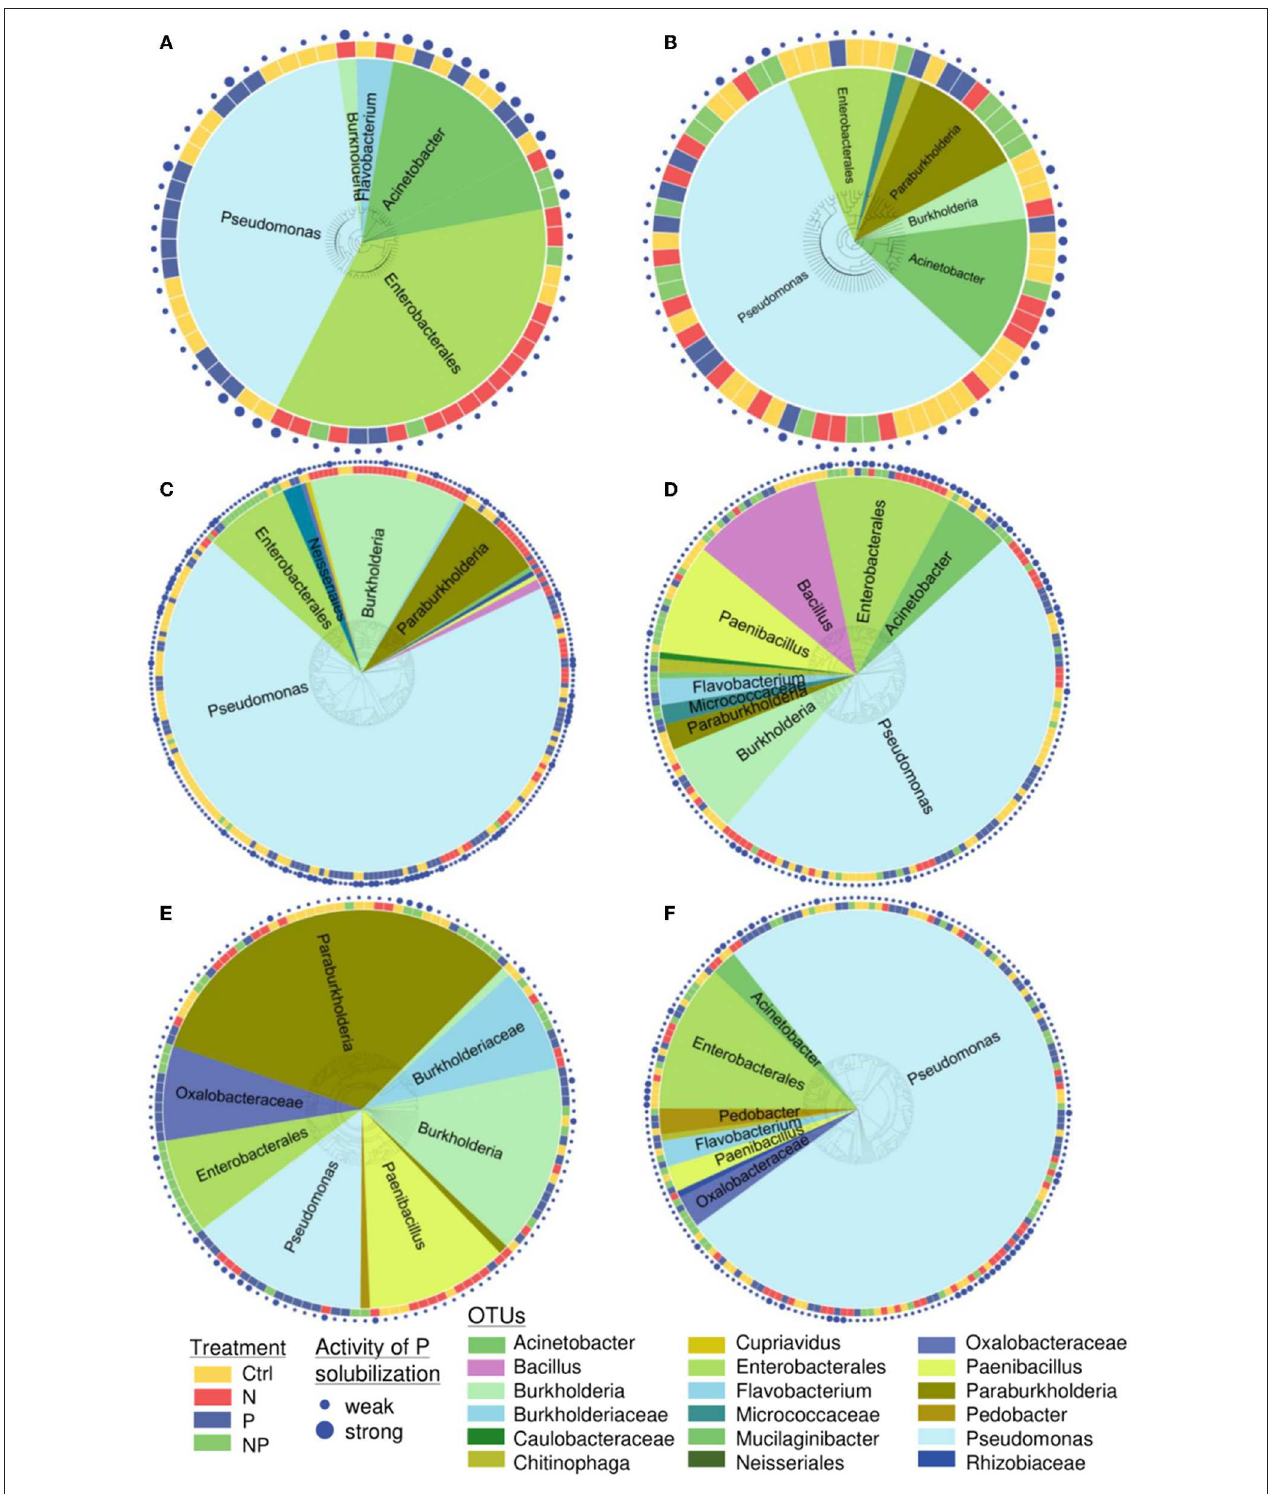
FIGURE 3 | Phylogenetic tree of all sequenced phosphorus-solubilizing bacteria at the site (A) Ukulinga (ukul.za), (B) Summerveld (summ.za), (C) Cedar Creek (cdcr.us), (D) Chichaqua Bottoms (cbgb.us), (E) Rookery (rook.uk), and (F) Heron’s Brook (hero.uk) in 0–15cm soil depth. At least 100 colony-forming units per sample were screened. Colors around the tree indicate the nutrient addition treatments. Colors inside the tree show the assigned name (OTU). The size of the dots around the tree indicates the activity of P solubilization (weak or strong).